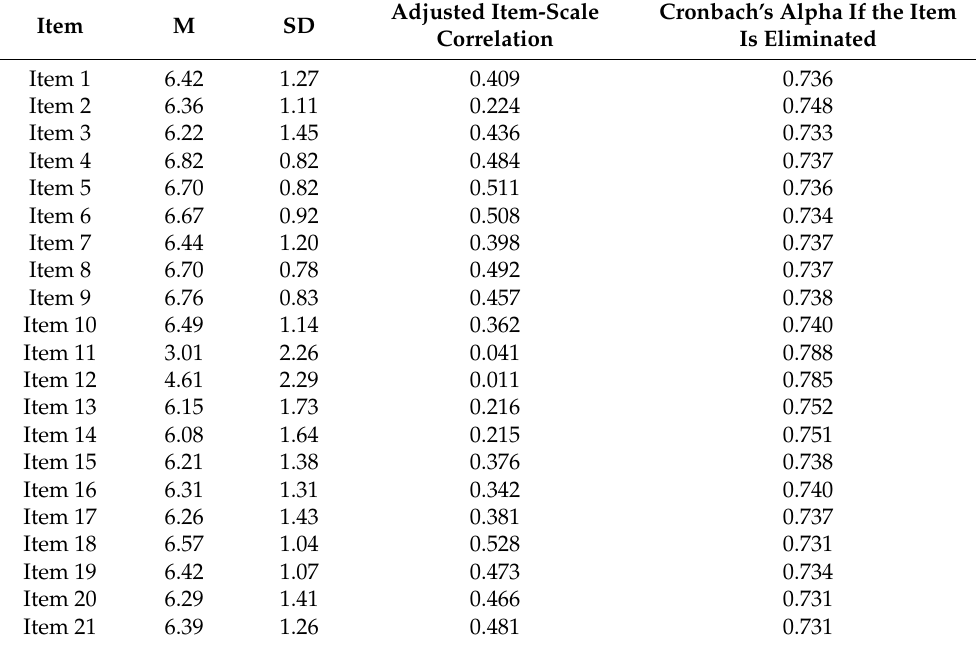
Table 4. Mean and standard deviation of each item considering full-scale items with total scale correlation after the elimination of items and Cronbach’s alpha if the item is deleted. Adjusted Item-Scale Cronbach’s Alpha If the Item Item M SD Correlation Is Eliminated